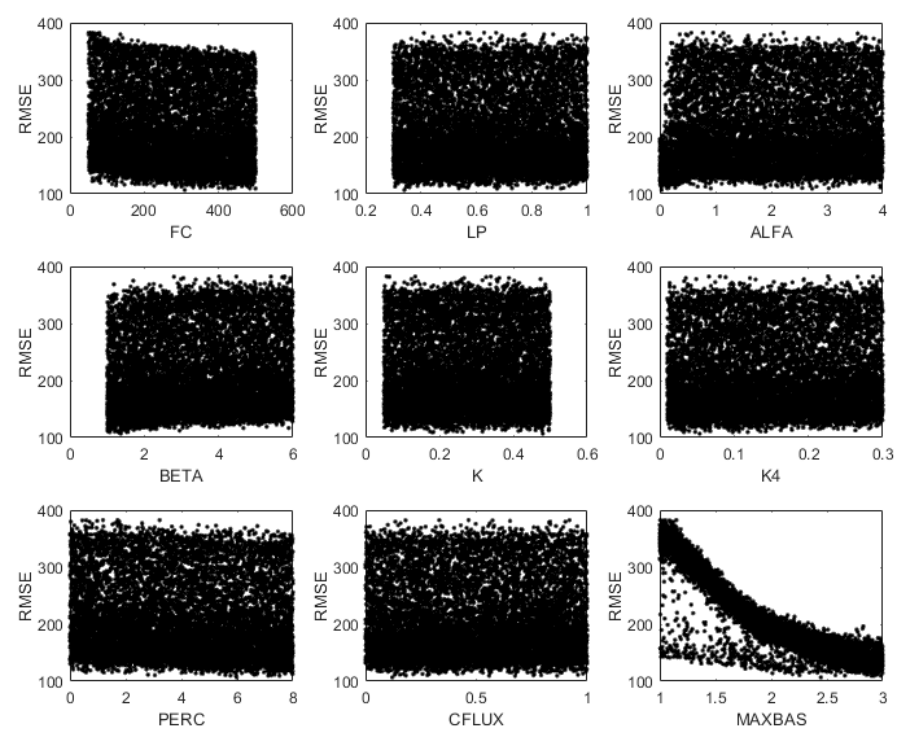
Figure 9. Scatter plot of RMSE against parameter values with 10,000 runs for HBV model.